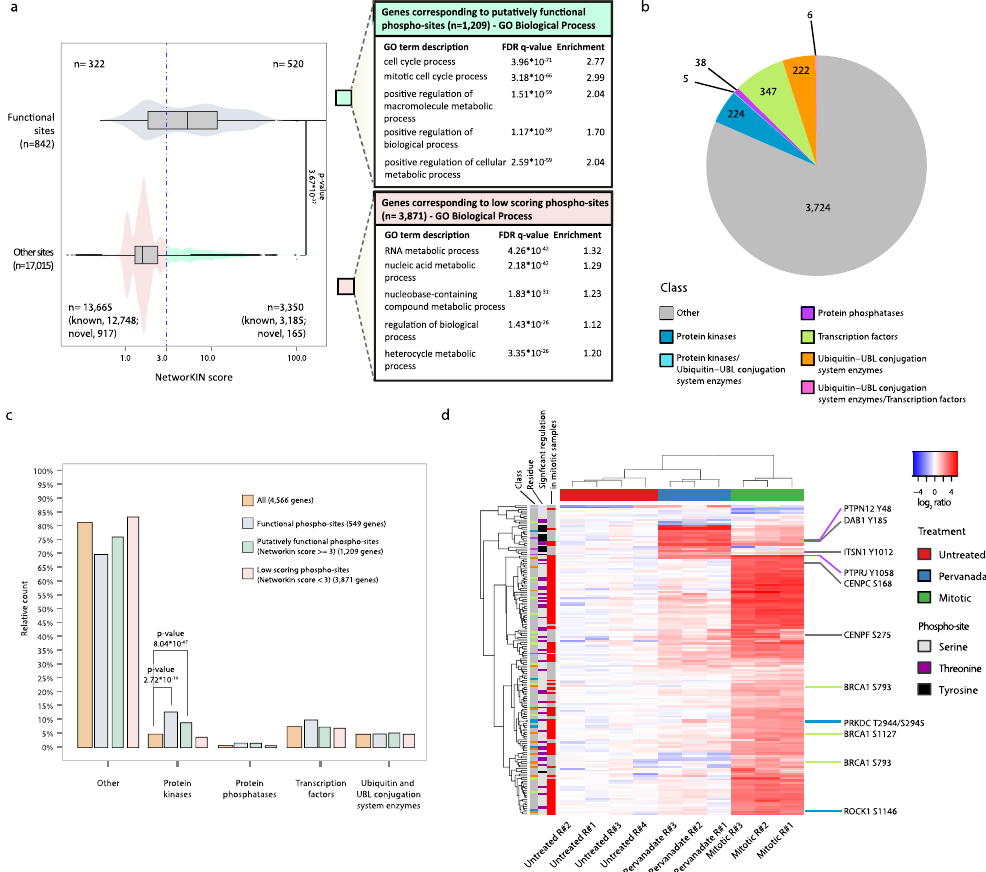
Figure 4. Novel phospho-sites have putative roles in mitotic regulation. ( a ) NetworKIN score distributions for the subsets of known functional phospho-sites or phospho-sites with no known function (Other sites). Two-sided t-test was performed to assess significance. A threshold score of 3 is used to separate a population of putatively functional phospho-sites and GO Biological Process enrichment analysis is performed on the score separated populations. ( b ) Number of genes identified for each of the examined classes in the phospho-HiRIEF analysis. Genes ascribable to more than one class are indicated in separate groups, with the classes separated by a “/” character. ( c ) Relative distribution of genes across classes for the subsets of genes corresponding to functional, putatively functional or low-scoring phospho-sites. Class enrichment in each subset compared to the class distribution for all genes identified in the Phospho-HiRIEF analysis is evaluated by Fisher exact test. Genes attributable to more than one class were excluded from this analysis. ( d ) Heatmap representing hierarchical clustering based on Euclidian distance and complete linkage of putatively functional novel phospho-sites. Row color-codings represent: “Class”, class of the protein carrying the indicated phospho-site (color coding as in Fig. 4b); “Residue”, modified residue; “Significant regulation in mitotic samples”, red – significant, grey - not significant. Detailed list of the phospho-sites included in the heatmap is provided in Supplementary Data